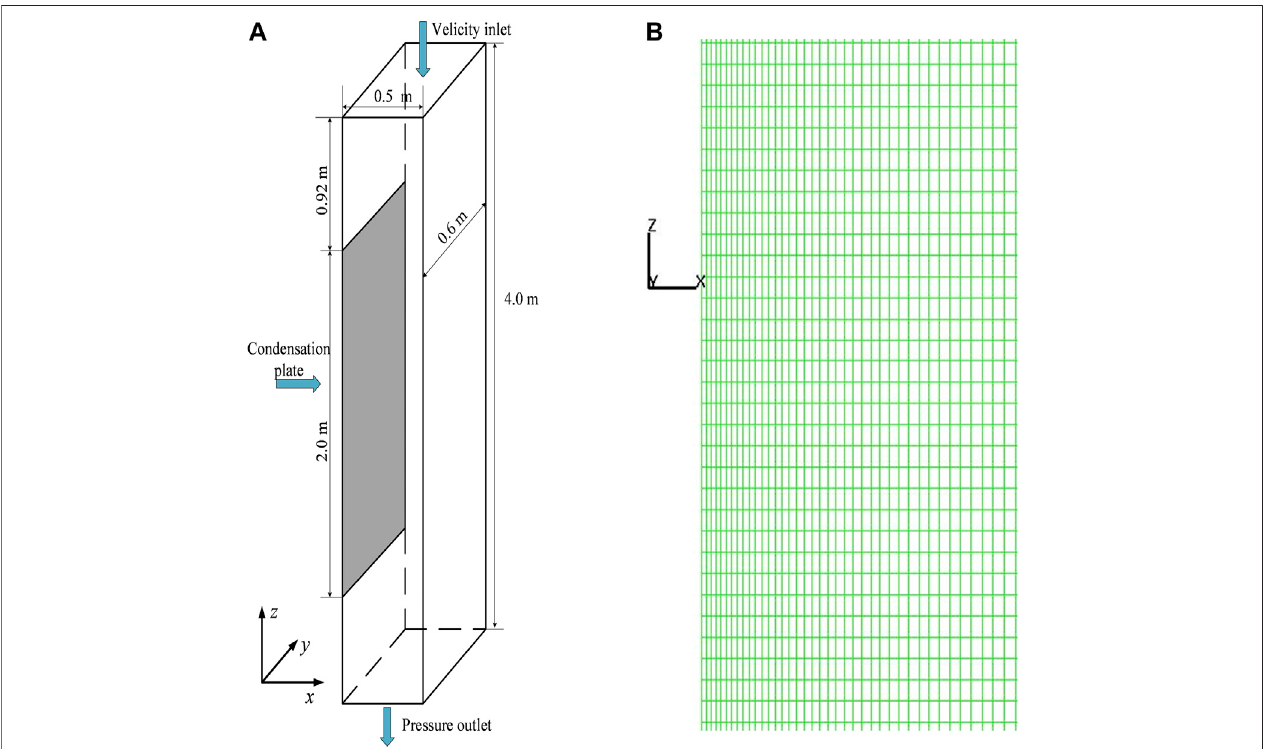
FIGURE 2 | Diagram of COPAIN test section and mesh. (A) Diagram of COPAIN test section. (B) Mesh division for x-z